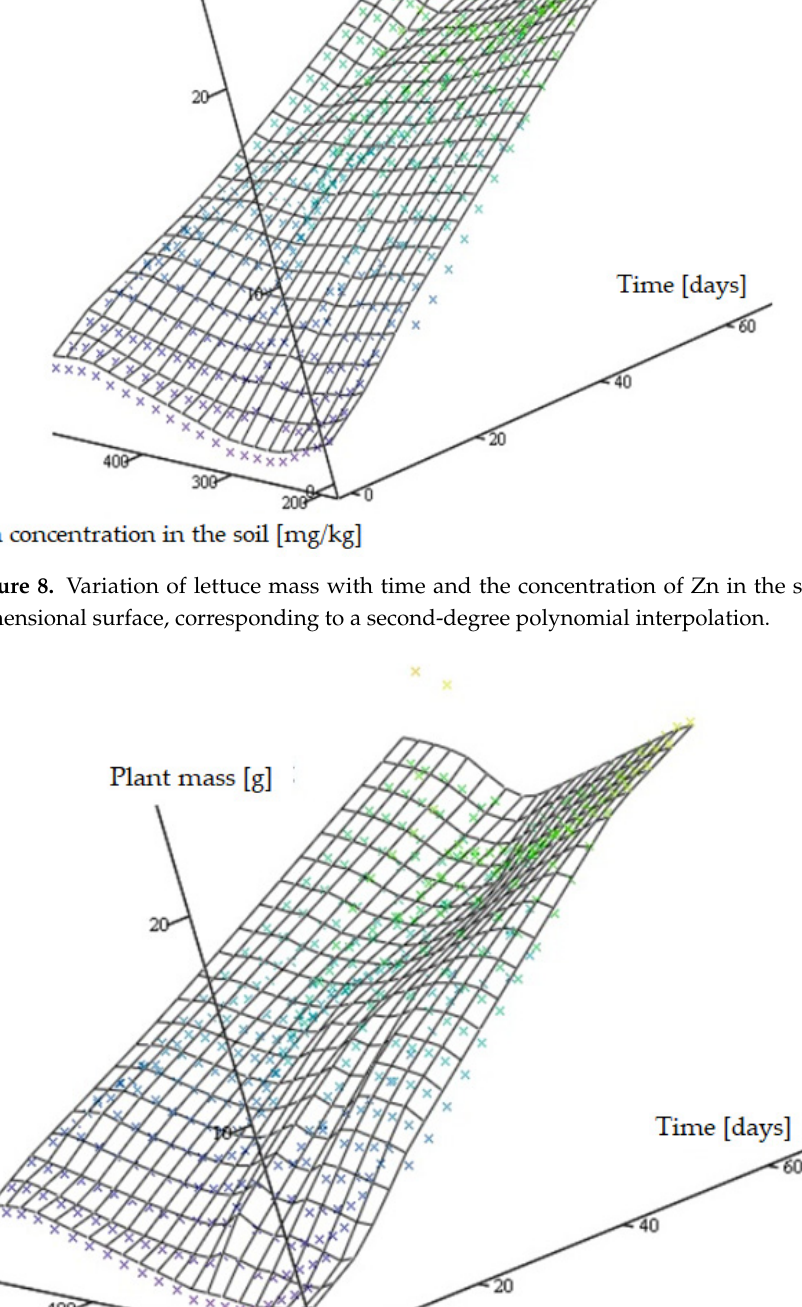
Figure 7. Variation of lettuce mass with time and the concentration of Zn in the soil, as a three- dimensional surface, corresponding to linear interpolation.